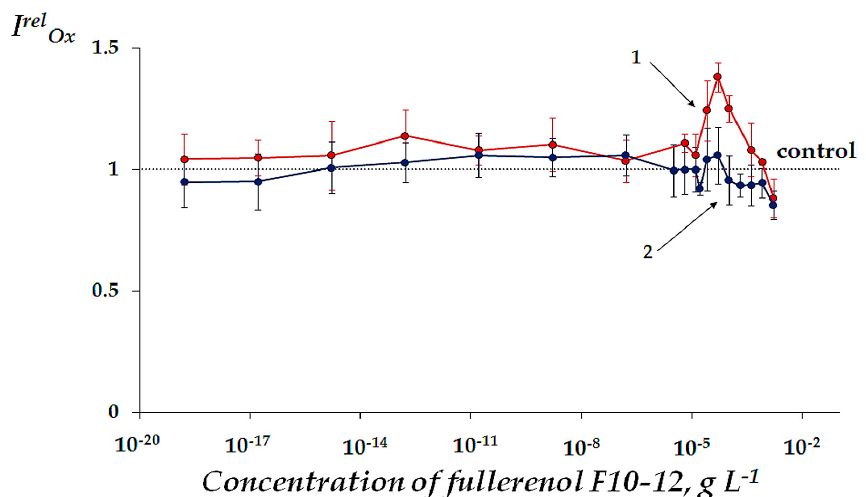
Figure 3. Antioxidant coefficients I rel Ox vs. concentration of fullerenol F10-12 in solutions of (1) 1,4-benzoquinone at EC 50 = 10 − 5 M and (2) K 3 [Fe(CN) 6 ] at EC 50 = 10 − 4 M.